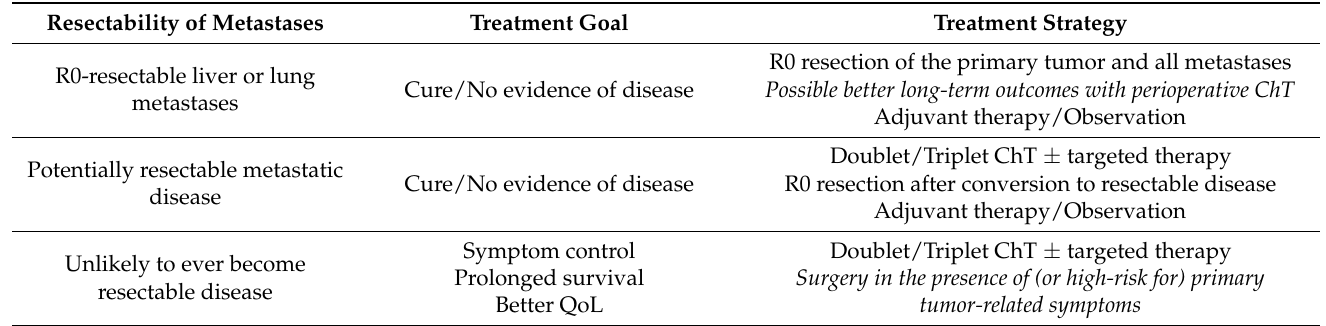
Table 1. Treatment of Colorectal Cancer with Liver/Lung